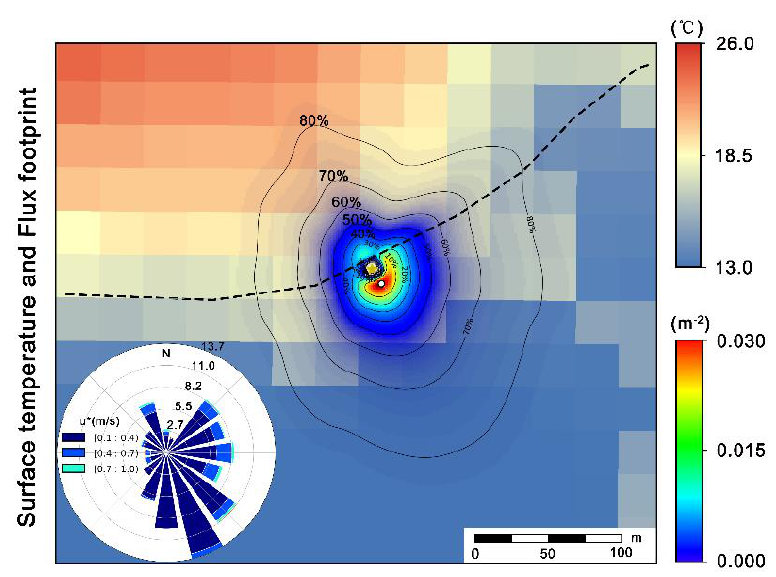
Figure 3. Flux footprint, surface temperature, and friction velocity at FOF in the daytime of summer 2017 (black line: wetlands boundary in summer 2017; Surface temperature is derived from landsat satellite data with a resolution of 30 m).